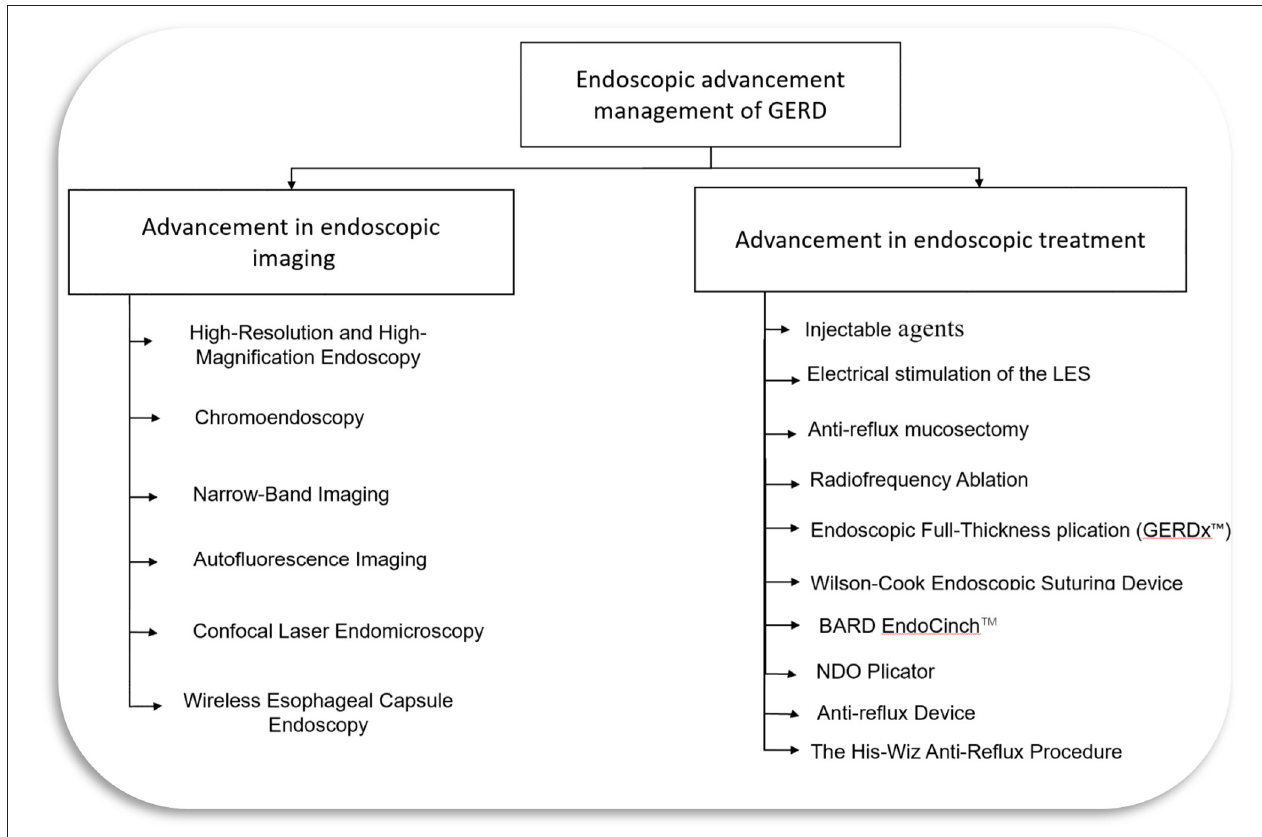
FIGURE 1 | Endoscopic management of GERD. LES, lower esophageal sphincter; GERD, Gastroesophageal reflux